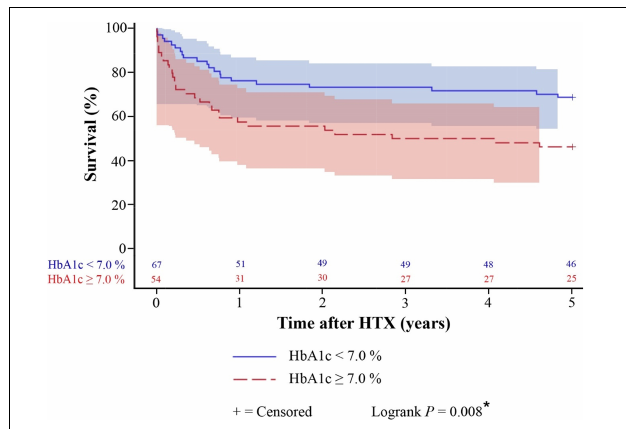
FIGURE 2 | Five-year post-transplant survival of patients with T2DM stratified by HbA1c at HTX (Kaplan–Meier estimator). Stratification of patients with T2DM at HTX showed a significantly lower 5-year post-transplant survival of patients with a HbA1c ≥ 7.0% at HTX (46.3%) in comparison to patients with a HbA1c < 7.0% at HTX (68.7%, P = 0.008). HbA1c, hemoglobin A1c; HTX, heart transplantation; T2DM, type 2 diabetes mellitus; ∗ , statistically significant ( P < 0.050).